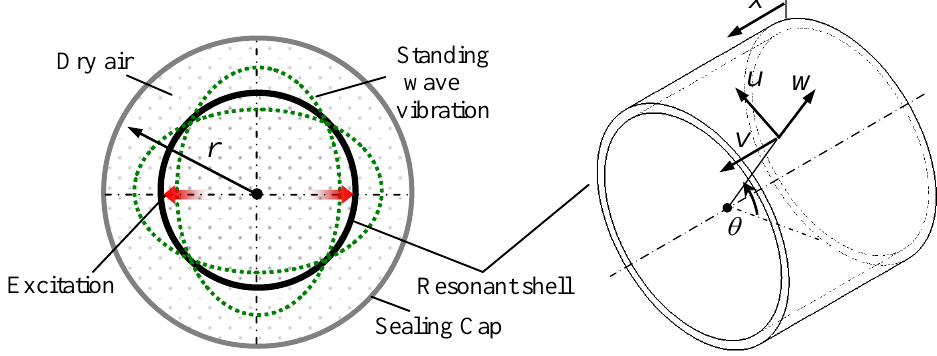
Figure 2. Schematic representation of the